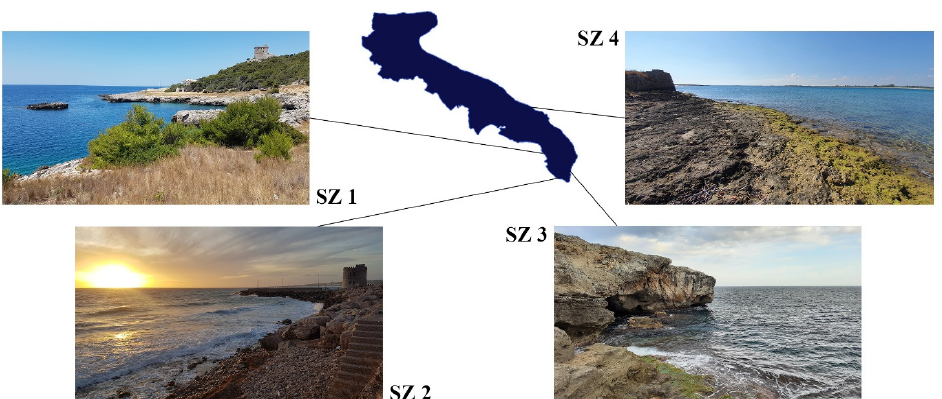
Figure 3. Sampling stations along the Salento peninsula. SZ 1—“Chiapparo”, Santa Caterina, Lecce (40°08 ′ 28.2 ″ N 17°58 ′ 46.1 ″ E); SZ 2—“Torre Vado”, Morciano di Leuca, Lecce (39°49 ′ 46.3 ″ N 18°16 ′ 38.6 ″ E); SZ 3—“Grotta Verde”, Marina di Andrano, Lecce (39°57 ′ 48.1 ″ N 18°24 ′ 18.2 ″ E); SZ 4—“Torre Guaceto” M.P.A., Brindisi (40°42 ′ 48.2 ″ N 17°48 ′ 30.5 ″ E).